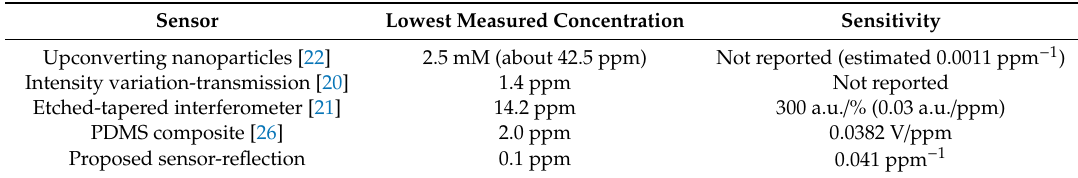
Table 1. Comparison between lowest measured concentration and sensitivities of different ammonia